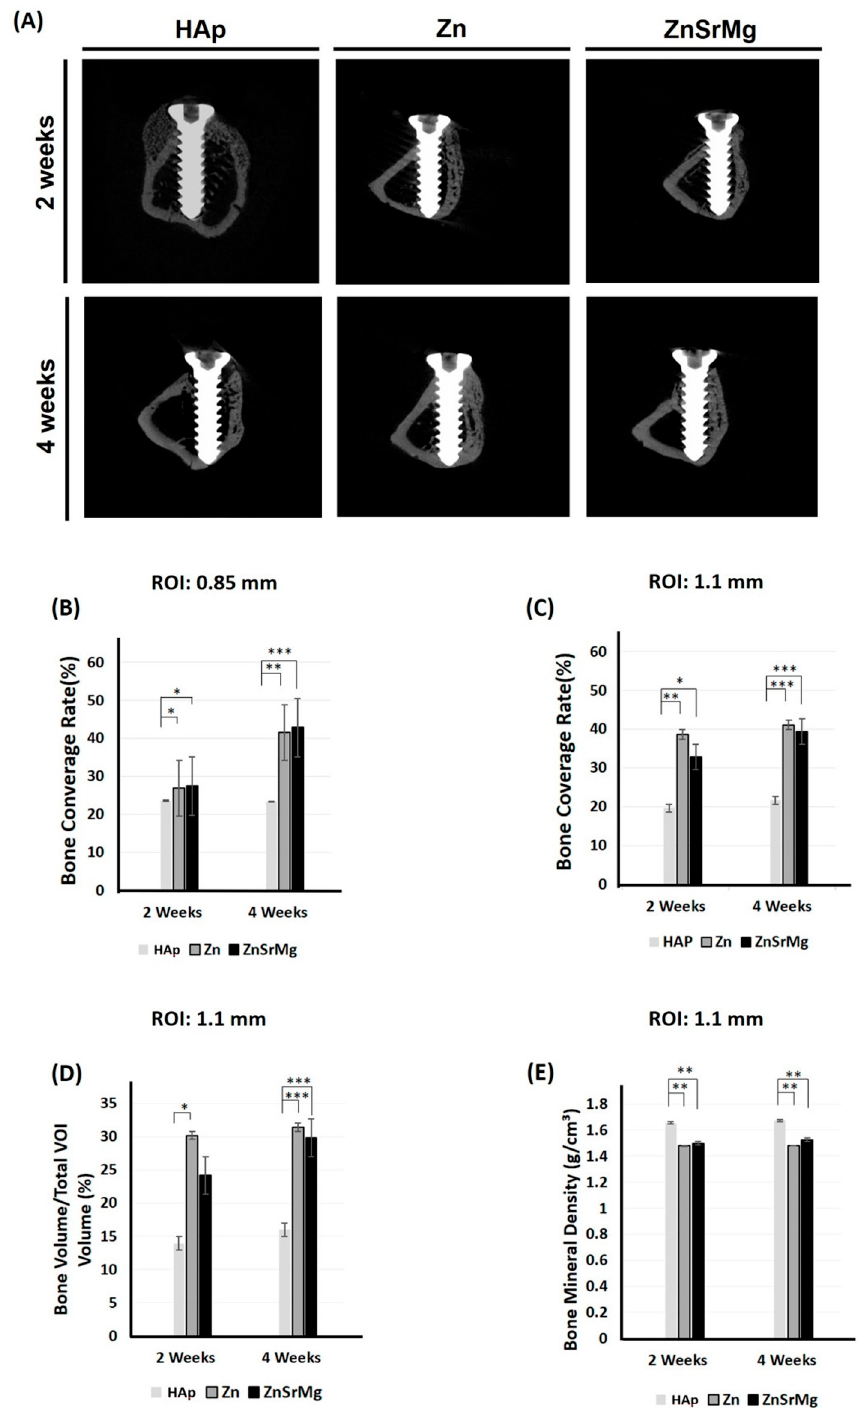
Figure 4. Measurement of new bone formation according to CT imaging. Micro-CT reconstruction images ( A ). New bone formation in the HAp, Zn-HAp, and ZnSrMg-HAp groups was recorded as bone coverage rate (%) (ROI: 0.85 mm ( B ); ROI: 1.1 mm ( C )), BV/TV (%) (ROI: 1.1 mm ( D )), and bone mineral density (g/cm 3 ) (ROI: 1.1 mm ( E )) at 2 and 4 weeks. ROI: region of interest, VOI: volume of interest. * p < 0.05, ** p < 0.01, *** p <